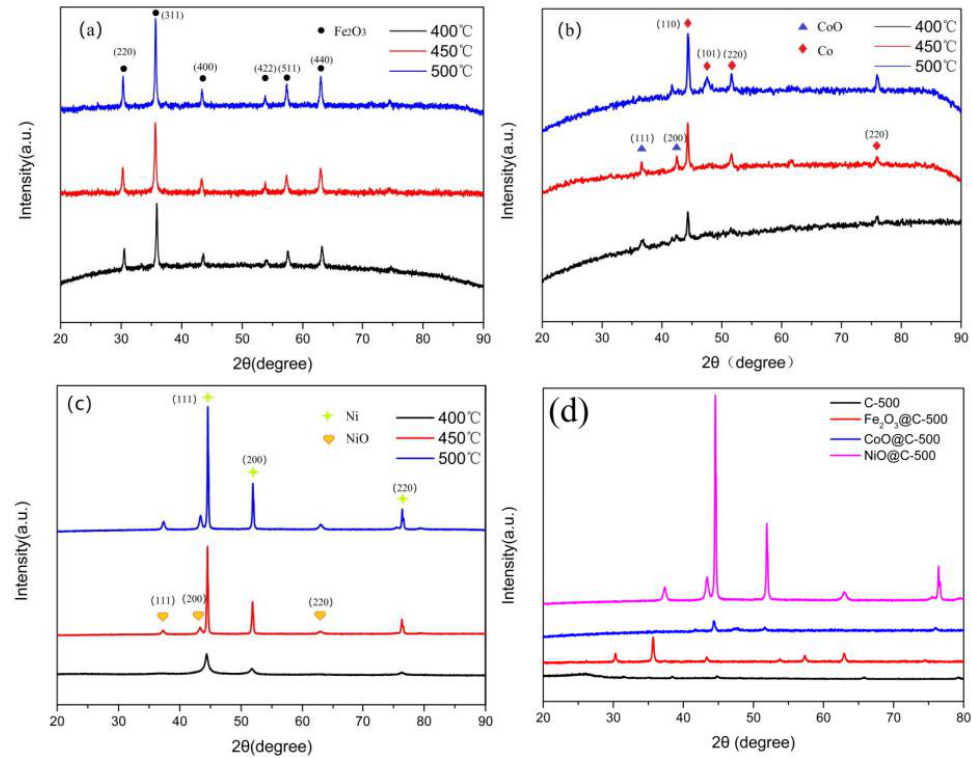
Figure 2. XRD patterns of Fe 2 O 3 @C ( a ), CoO@C ( b ), and NiO@C ( c ) at different calcination temperatures, and the Fe 2 O 3 /CoO/NiO@C-500 ( d ).